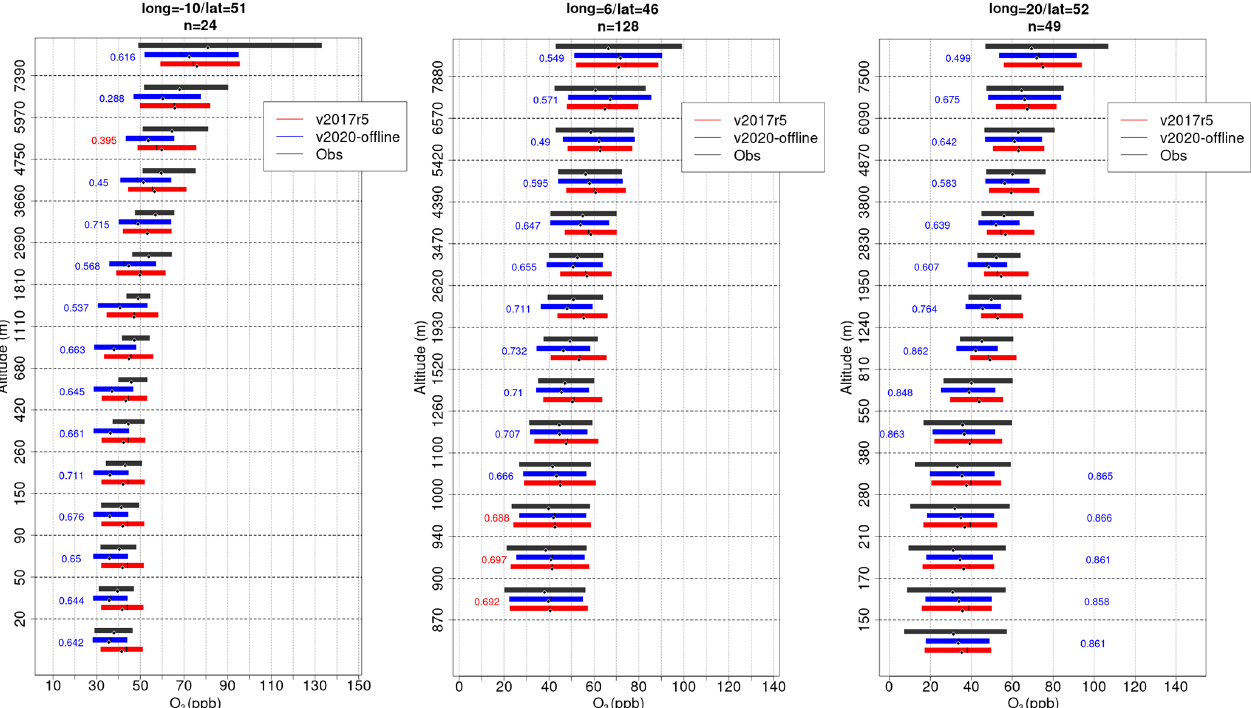
Figure 6. O 3 vertical profiles for three stations across Europe. Coordinates of the stations are given at the top of each plot. Each bar represents the spread (10% to 90% quantiles) of the data for the two versions (blue and red) and observations (gray). The value on each level represents the correlation for the model with the higher correlation with the same color. The small white dot on each bar represents the average.